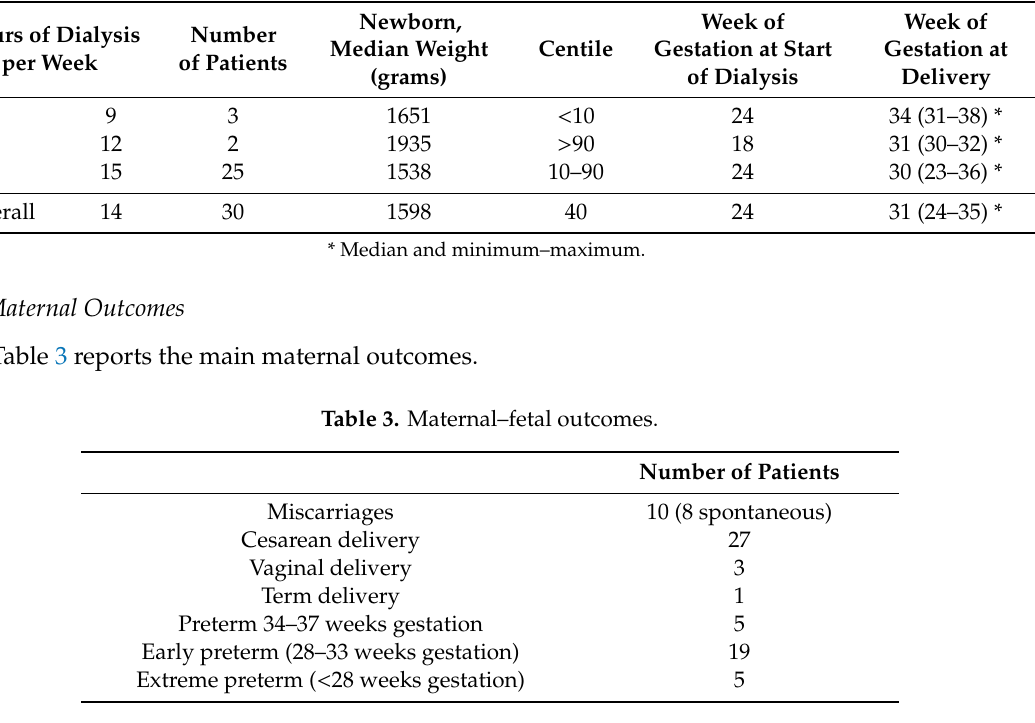
Table 2. Outcomes according to hours of hemodialysis per week.